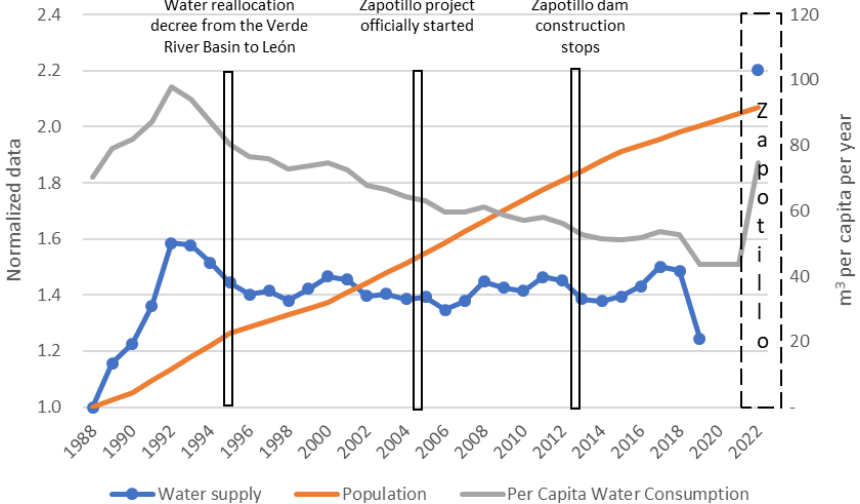
Figure 2. The reservoir effect in León (the dashed rectangle denotes the projected new water demand of a large new supply-augmentation scheme). Sources of data: INEGI (1990, 1995, 2000, 2005, 2010, 2015), CONAPO (2015), CEA Guanajuato and Conagua (2018), and SAPAL